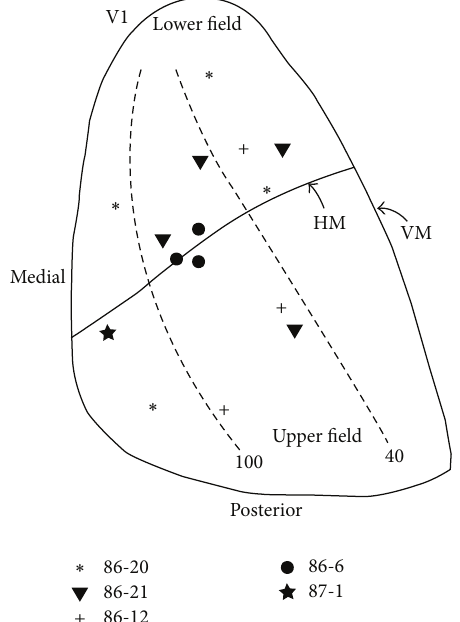
Figure 4: Schematic map of the visual field in right rabbit V1 [35] showing the approximate locations within V1 of 14 tracer injections performed in 5 albino rabbits. The representation of the horizontal meridian is approximate. All injections in the same animal are represented by the symbol next to the respective case number. The tracers used in each animal are indicated in the text. HM: horizontal meridian, VM: vertical